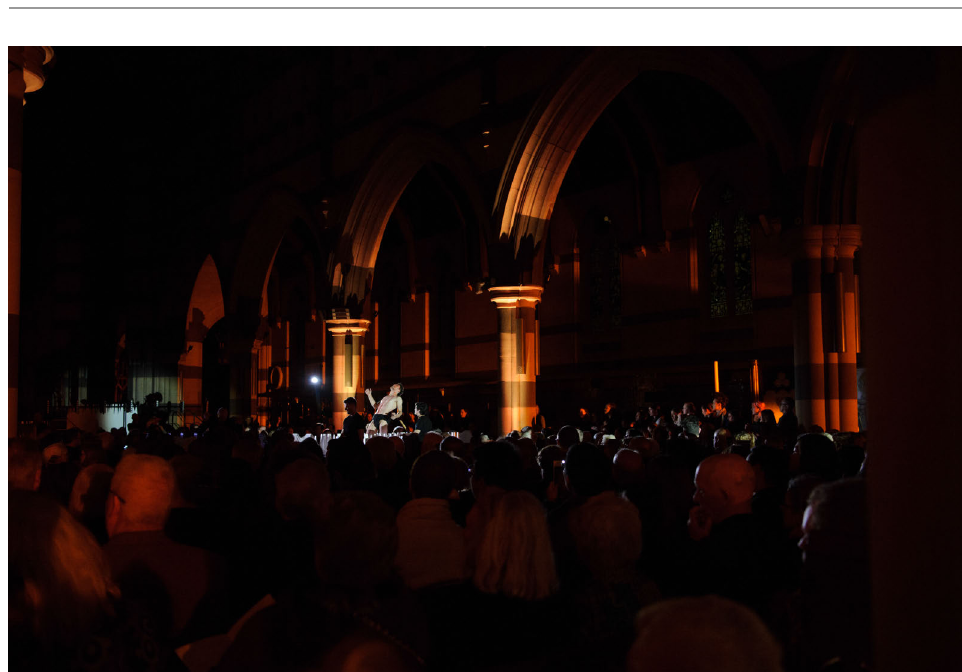
FFigigururee 66.. Jesus suffering. (Photo: Sarah Walker)